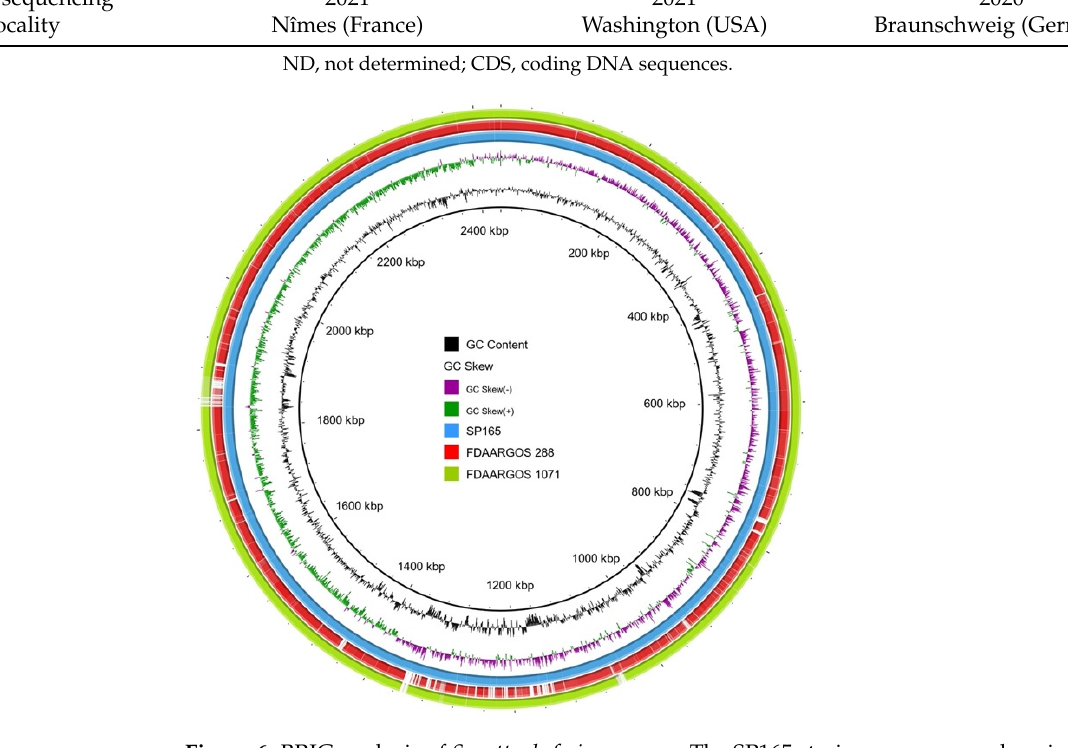
Figure 6. BRIG analysis of S. pettenkoferi genomes. The SP165 strain was compared against the two genomes previously described in the literature. The inner blue ring represents the SP165 genome; the middle red one shows the FDAARGOS 288 genome after BLASTn match; while the outer green ring corresponds to FDAARGOS 1071. Only regions with >90% nucleotide identity are colored. Lower identity percentage or no match are represented by blank spaces in each ring. The inner bicolor ring corresponds to the GC skew of S. pettenkoferi SP165 isolates. Green profile indicates overabundance of GC nucleotides, whereas purple shows the opposite. The inner black ring represents the GC%.